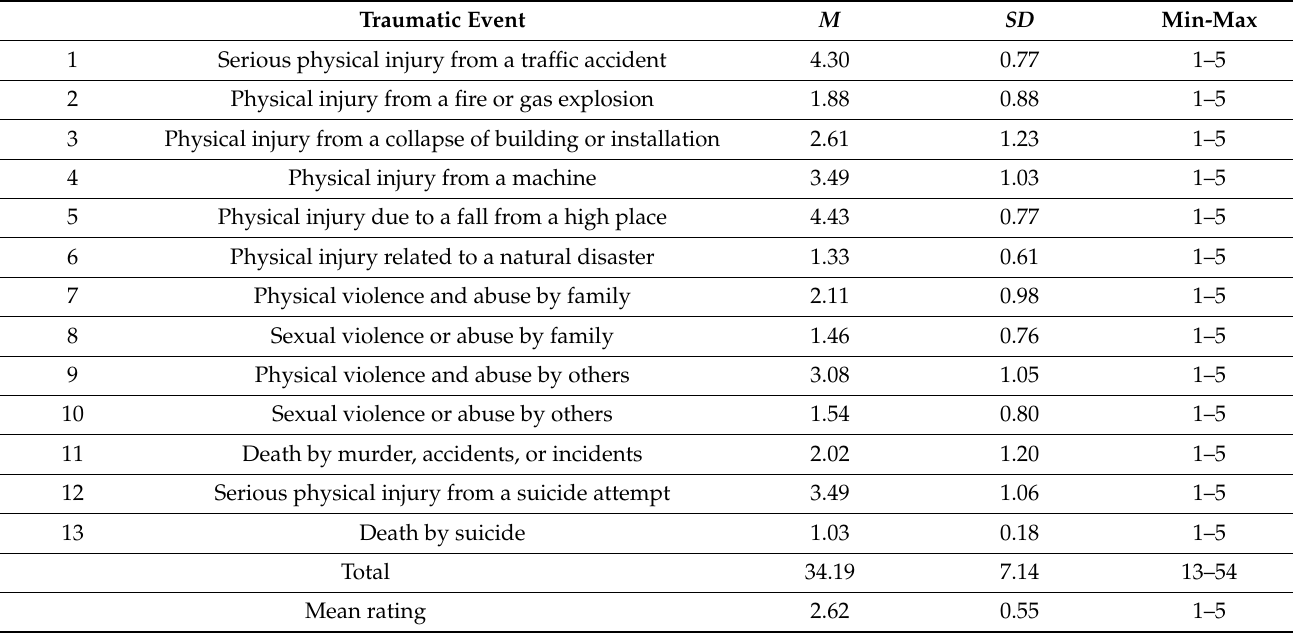
Table 2. Frequency of traumatic event experience among participants (N =